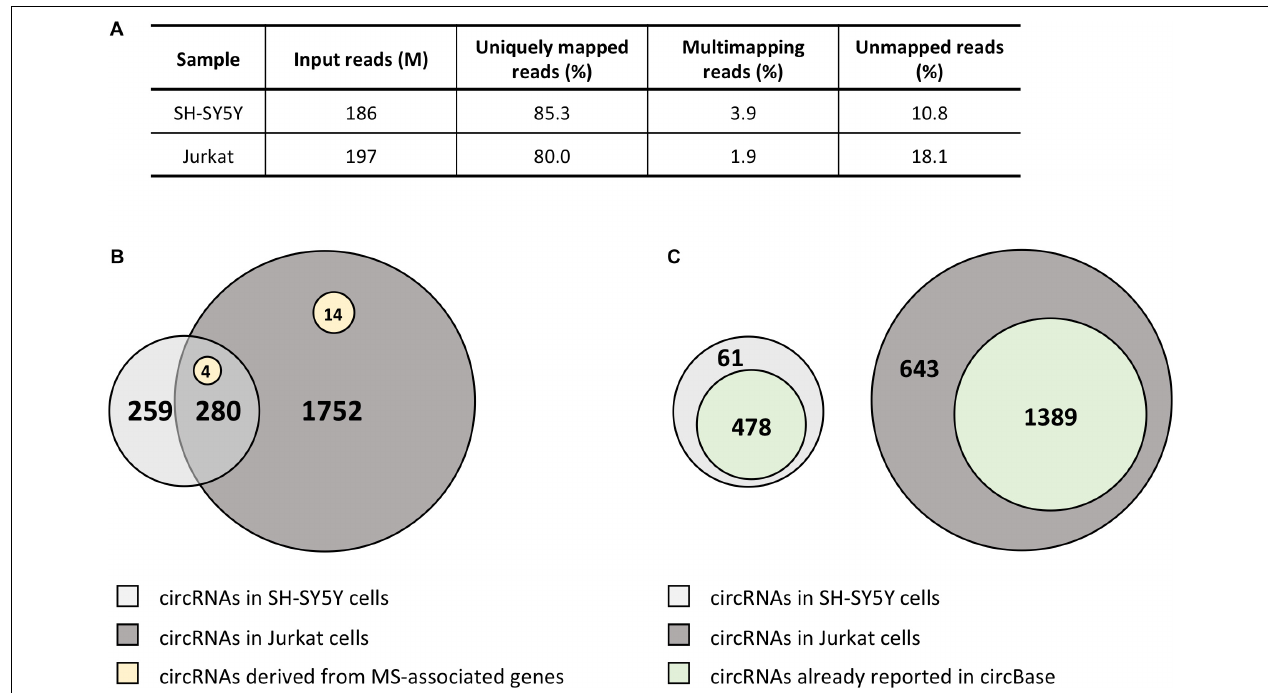
FIGURE 2 | CircRNA landscape of SH-SY5Y and Jurkat cells. (A) Table showing alignment statistics of RNA-seq experiments in SH-SY5Y and Jurkat cells. M, million reads. (B) Venn diagrams representing the number of circRNAs shared by SH-SY5Y and Jurkat cells. The number of circRNAs identified only in one cell type is also shown. Yellow circles represent those circRNAs derived from MS-associated genes. (C) Venn diagrams representing the number of circRNAs that were already described in circBase for each cell